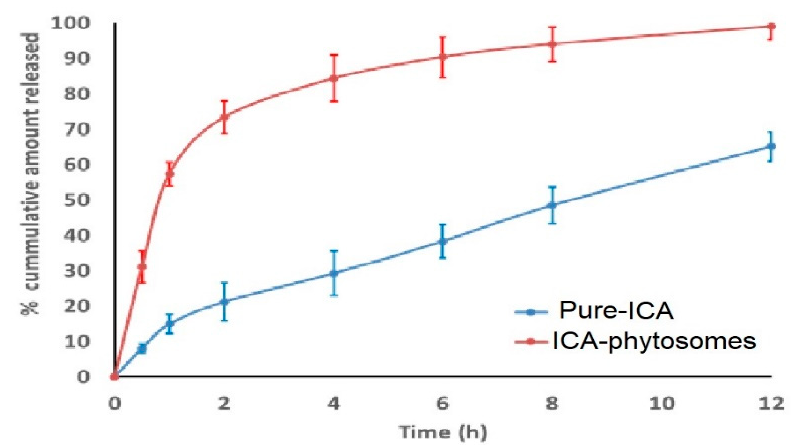
Figure 6. In vitro release profile of optimized ICA-phytosomes compared to pure-ICA in phosphate- buffered saline (PBS) buffer pH 7.4 at 37 ± 0.5 °C. (Results are presented as mean ± SD, n = 3) .